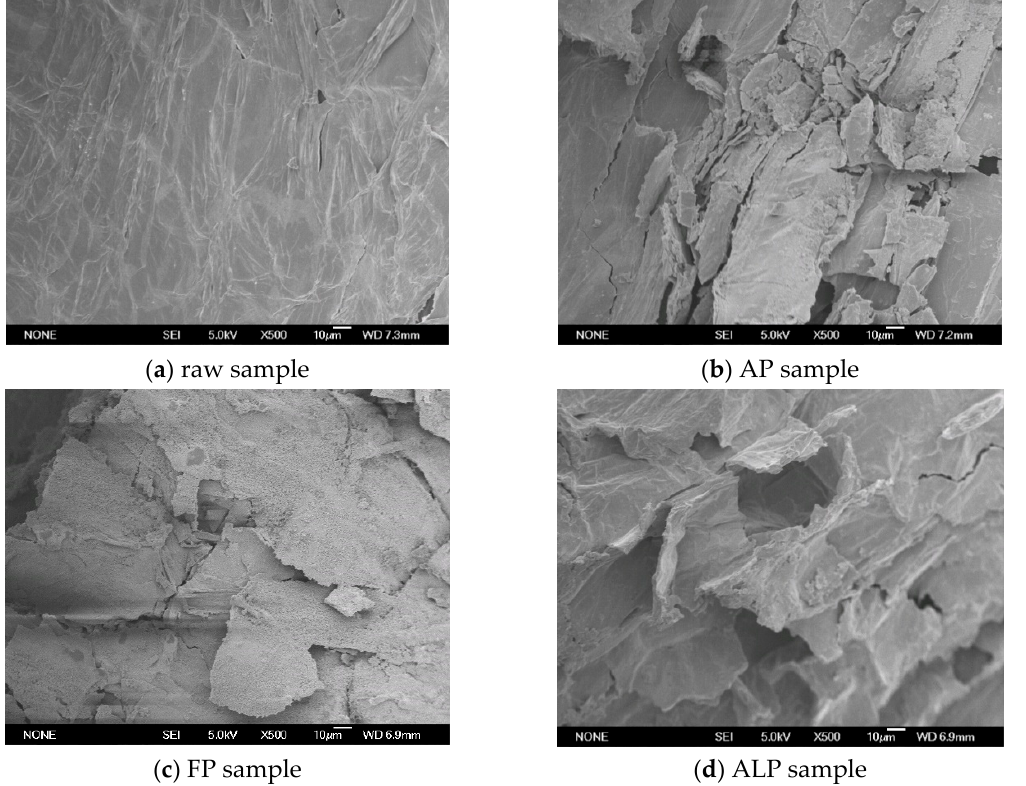
Figure 1. SEM images of raw stalk and pretreated stalk samples (500×). ( a ) raw sample; ( b ) AP sample; ( c ) FP sample; ( d ) ALP sample.